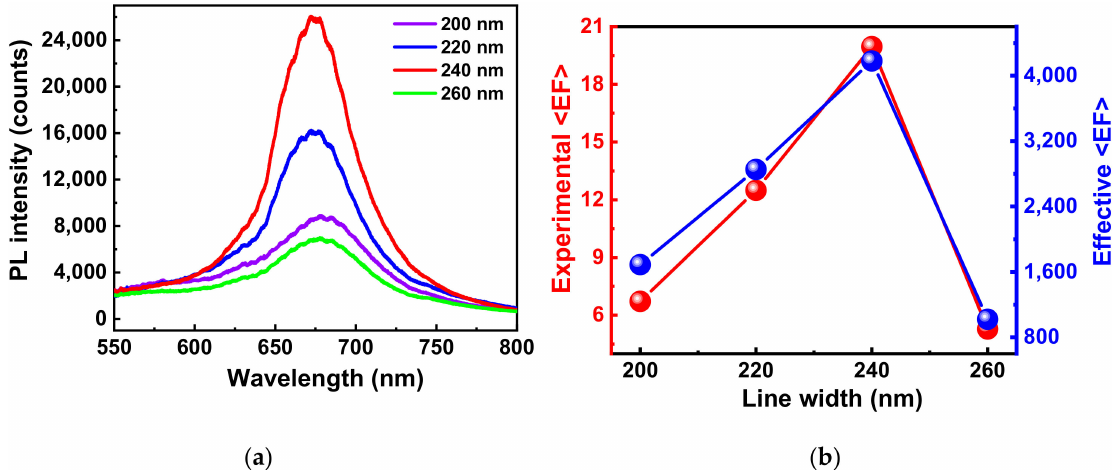
Figure 4. ( a ) Enhanced PL spectra for the MoS 2 / nanogap hybrids constituted of nanogaps with di ff erent lengths. ( b ) Experimental and e ff ective PL enhancement factors as a function of the nanogap